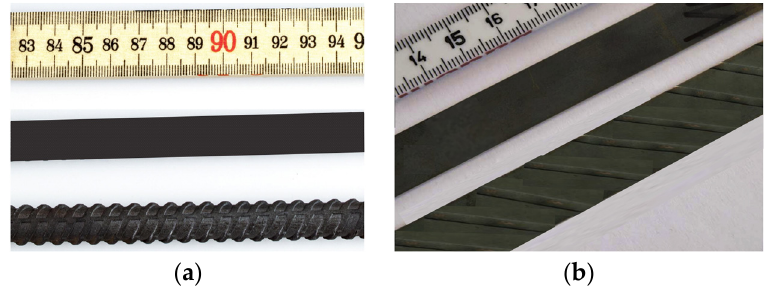
Figure 4. Schematic diagram of Fe-SMA [71,72]: ( a ) Fe-SMA bars, ( b ) Fe-SMA strips.